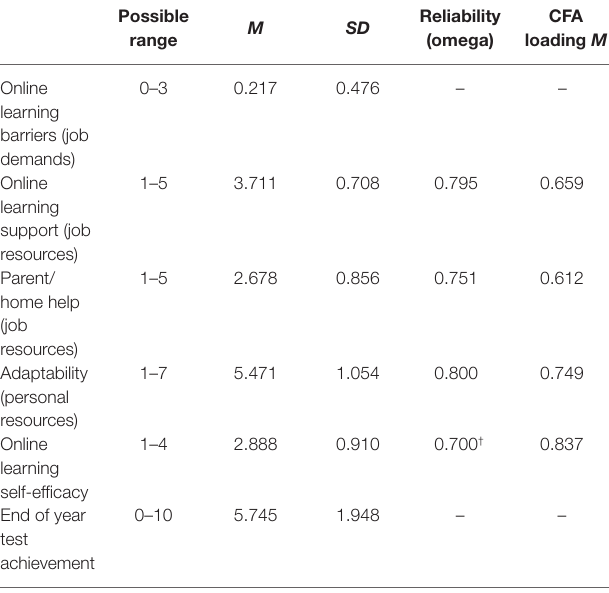
TABLE 1 | Descriptive and measurement